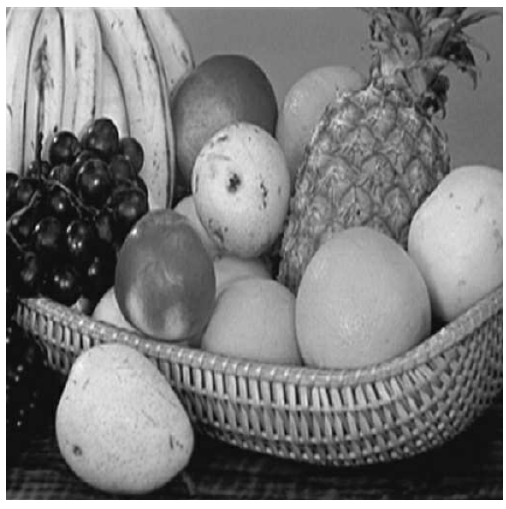
Fig. 1: Original image